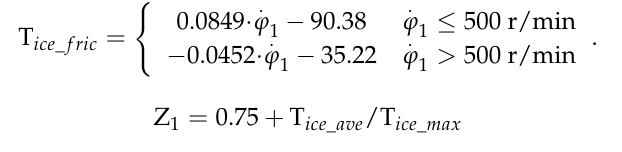
Table 2. Dynamic parameter determination and correction values.